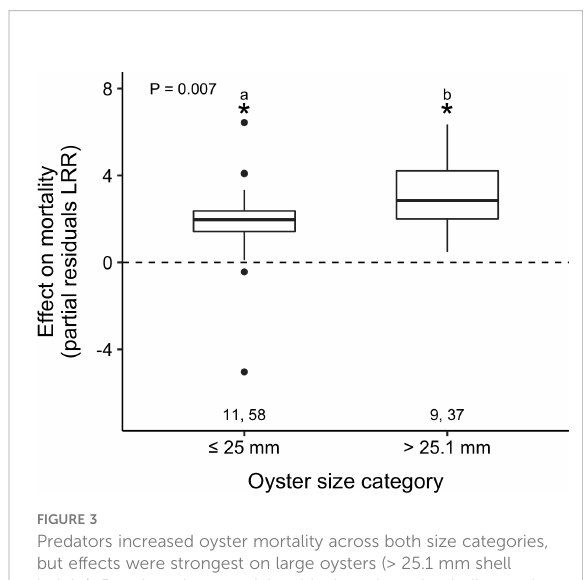
FIGURE 3 Predators increased oyster mortality across both size categories, but effects were strongest on large oysters (> 25.1 mm shell height). Boxplots show partial residuals and p-value indicates the respective main effect displayed from mixed-effects models. Lowercase letters represent results from post-hoc tests and those that do not share a common letter are signi fi cantly different ( p ≤ 0.05). Pairs of numbers and asterisks as in Figure